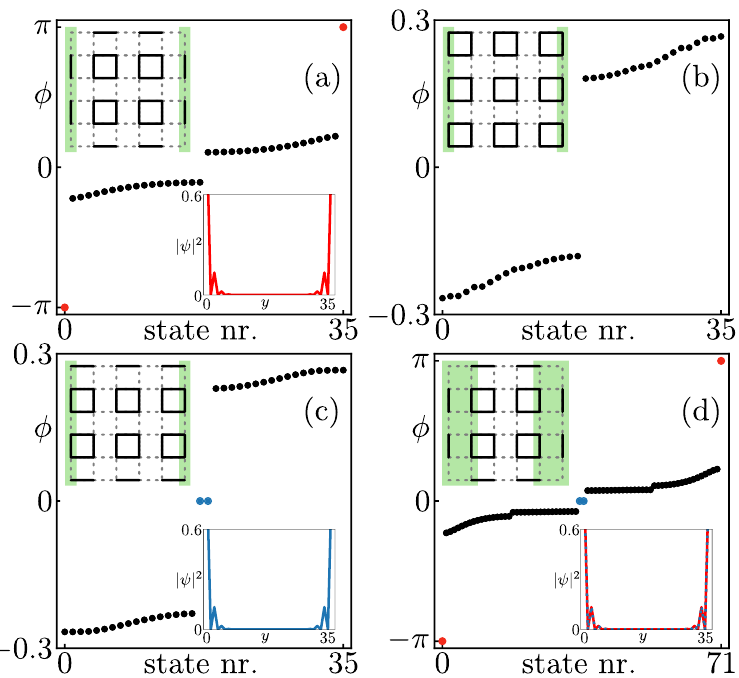
Figure 2: Eigenphases of the reflection matrix, showing π -modes (0-modes) and = 1 in their associated wavefunctions in red (blue). The HOTI parameters are λ x , y = 0.4 in panels (a) and (d), γ = 1.2 in panel all panels. We have chosen γ x , y x , y = 1.2 and γ = 0.4 in panel (c). Insets sketch the corresponding (b), whereas γ x y dimerization pattern of the HOTI as well as the sites connected to the lead (green). = 0.5 in all cases. The gap around φ = 0 The system-lead coupling strength is t sl as well as the bandwidth of the bulk states (black) is proportional to t in the weak sl coupling